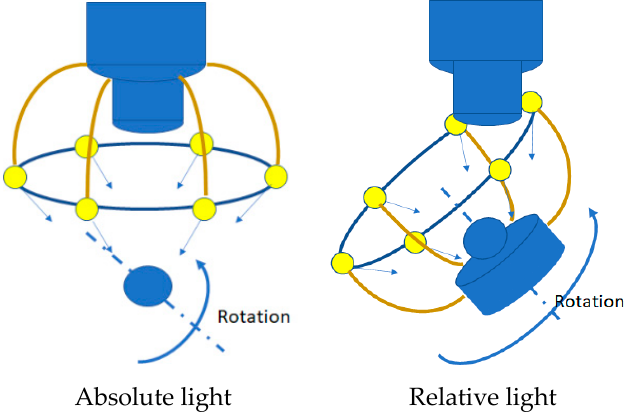
Figure 5. Ambient light control for SfM in microscale.